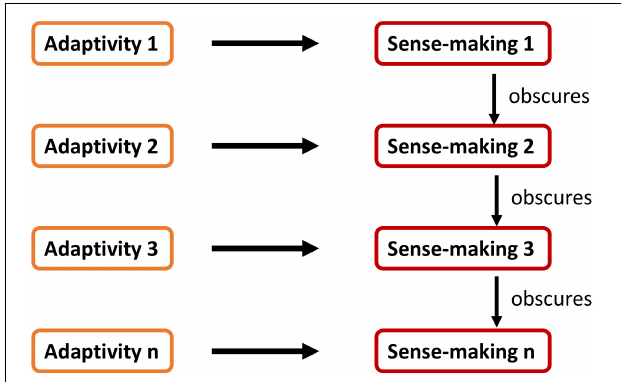
FIGURE 1 | A simplified model of various sense-making processes that depend on respective acts of adaptivity; in this case, sense-making1 is most apparent in the agent’s experience.